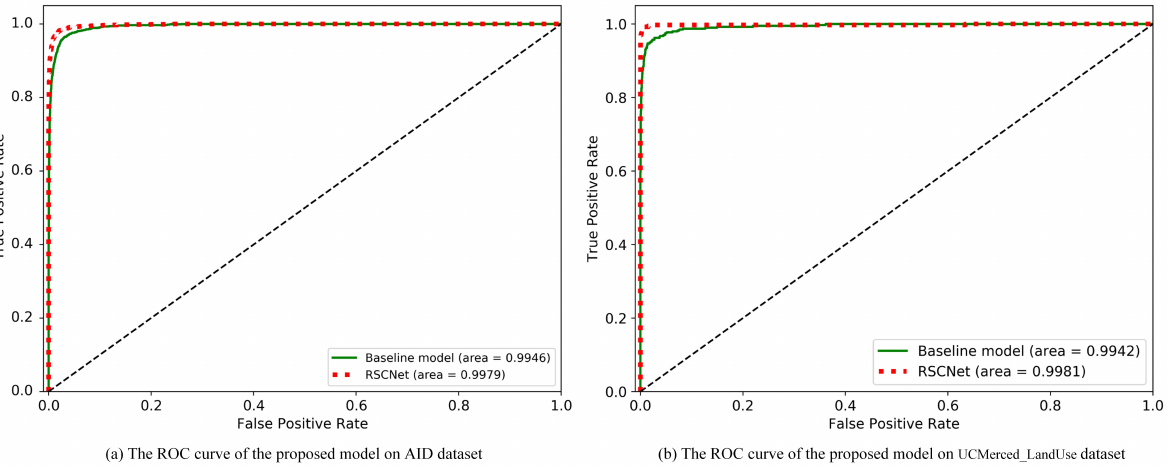
Figure 9. The ROC curves of the proposed model on two